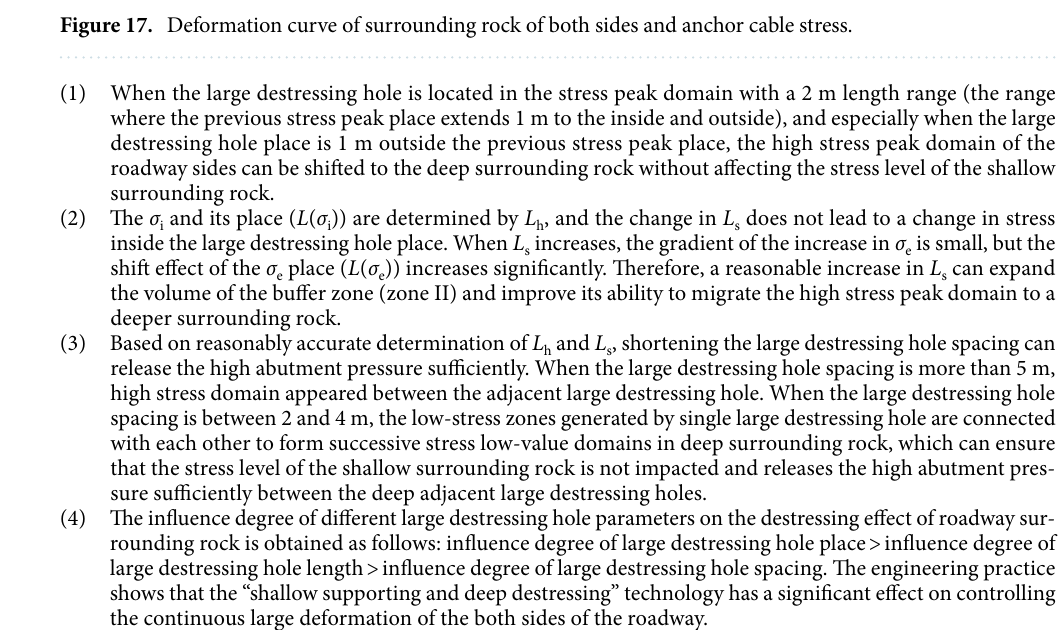
Figure 17. Deformation curve of surrounding rock of both sides and anchor cable